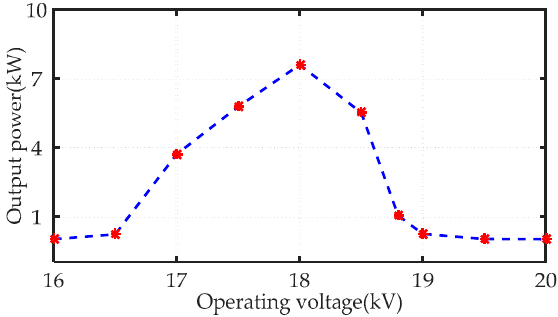
Figure 4. The changing of output power with operating voltage.